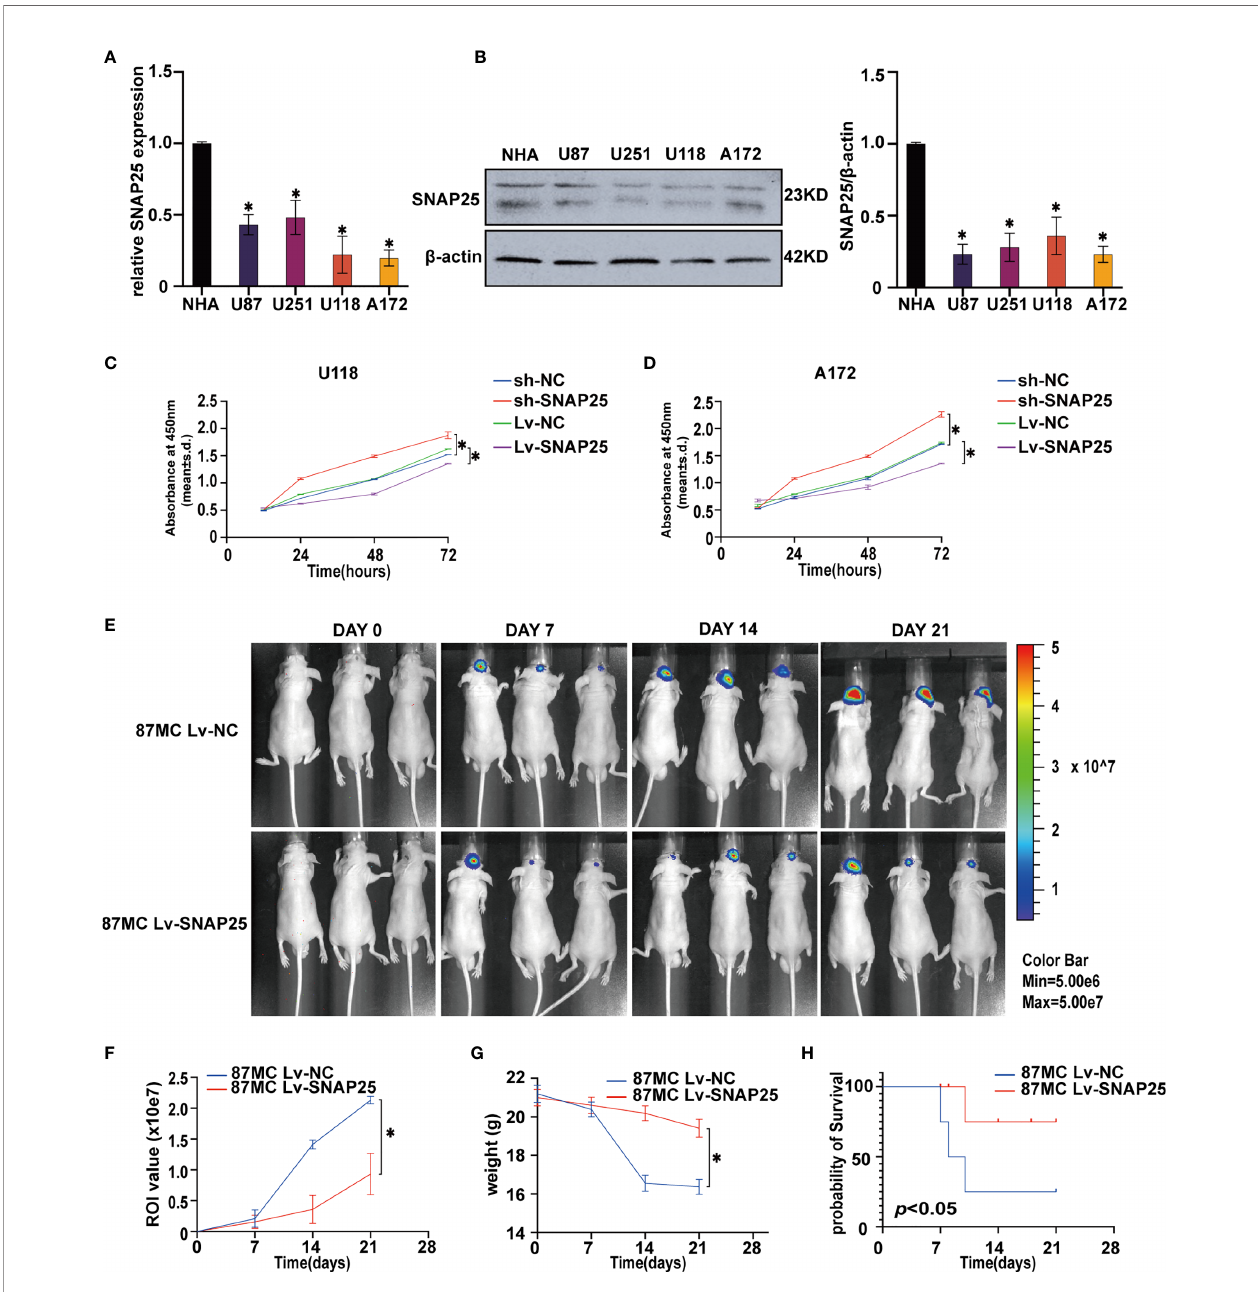
FIGURE 2 | Overexpression of SNAO25 inhibits glioma cell growth in vitro and in vivo . (A) Relative SNAP25 expression levels in various glioma cell lines, compared with the normal human astrocytes (NHA), * p < 0.05 compared with NHA cells. GAPDH was used as a housekeeping gene. (B) The level of SNAP25 protein was detected in 4 glioma cell lines and NHA by western blot. * p < 0.05 compared with NHA cells. B-actin was used as a control and the barplot besides shows the representative SNAP25/actin ratio regarding to the western blot. (C, D) Ectopic expression of SNAP25 inhibits cell growth as determined by CCK-8 assay. * p < 0.05 compared with Lv-NC or sh-NC group. (E) Tumor growth was monitored over time (up to Day 21) by measuring luciferase emission (ROI). (F – H) The ROI value, weight of the mice and the probability of survival was recorded over